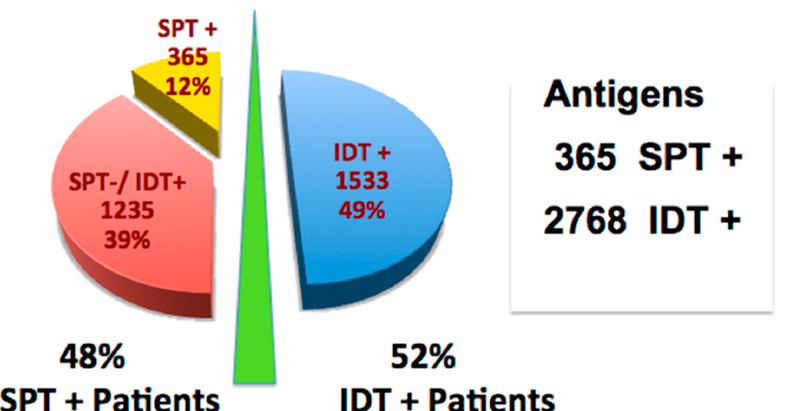
Figure 3. Benefit of adding IDT to SPT. Total of 3133 allergens discovered among 371 patients. IDT identified 1235 more treatable allergens among SPT+ patients (groups D and E) than SPT alone (365) (Chi Square p < 0.001, 95% CI: 0.47, 0.36; odds ratio 0.09; 95%CL: 0.05 to 0.15). Even in the high-sensitivity group (groups D and E), the majority of positive aller- gens were found with IDT, using larger doses of antigen than can be applied by SPT.